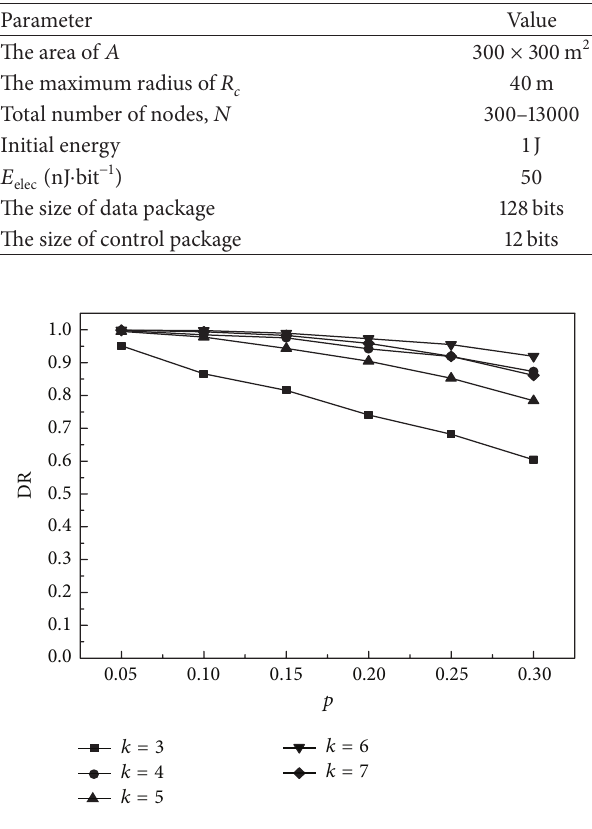
Figure 6: The relationship of DR with 𝑝 .